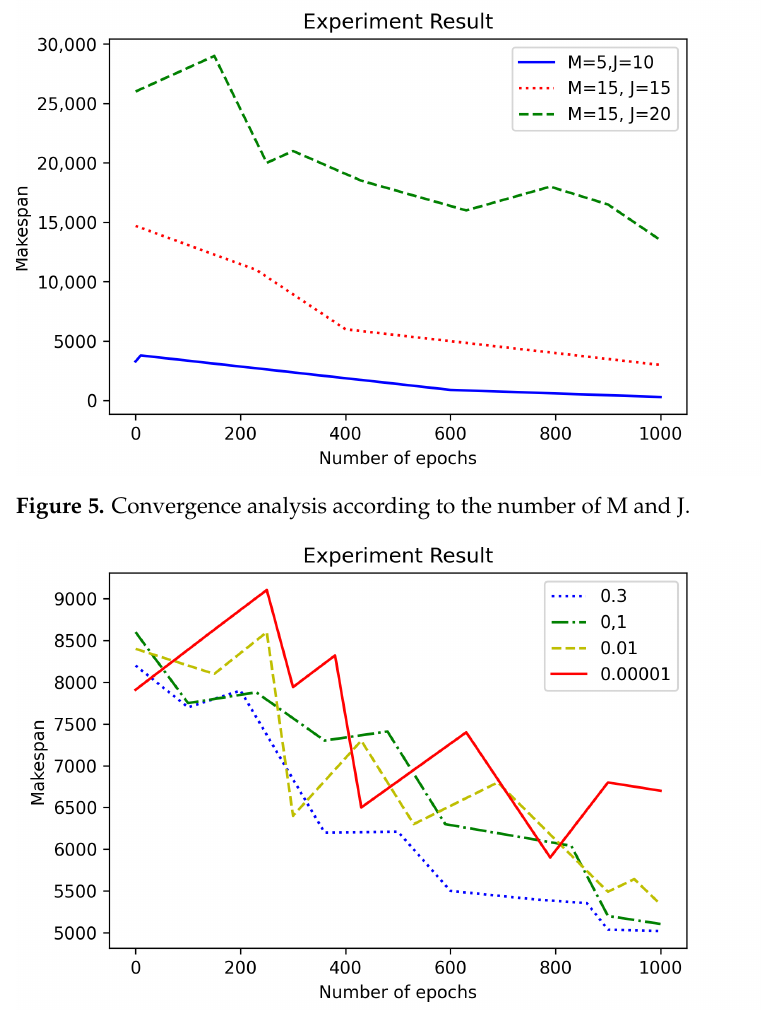
Figure 6. Convergence analysis according to the difference in parameter (cid:101)